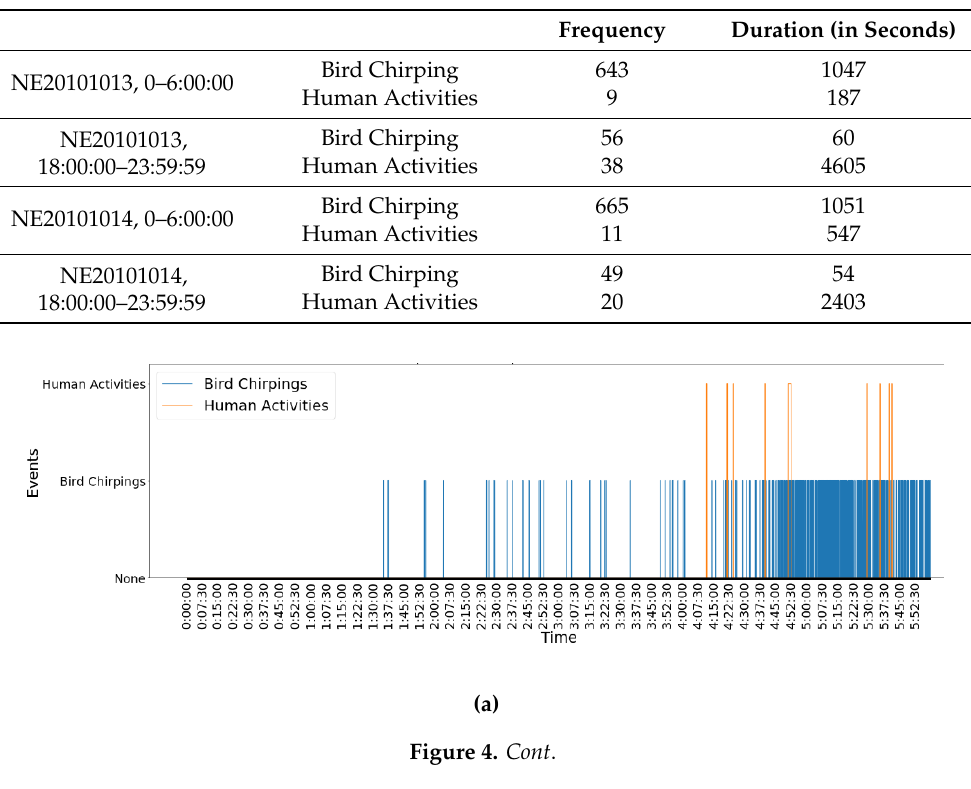
Table 4. Frequency and duration analysis.